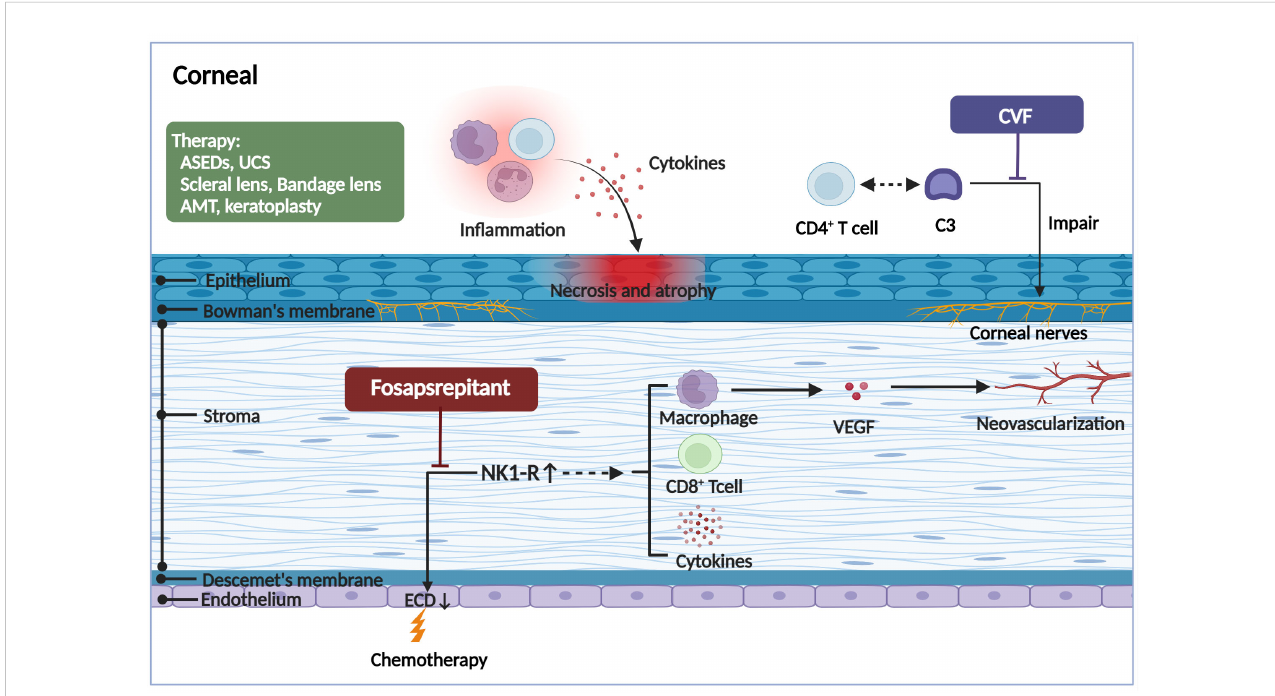
FIGURE 3 The pathogenic mechanism in the corneal of ocular GVHD and treatment. The corneal may appear the corneal epithelial impairment, a lower endothelial cell density, hemangiogenesis, and corneal neurosensory abnormalities in ocular GVHD. The corneal epithelial impairment including atrophy and necrosis, the vacuolization of epithelial basal cells, and stromal edema, all of which are likely associated with the in fi ltration of immune cells and the stimulation of in fl ammatory cytokines. The reduction of the corneal endothelial cells and formation of neovascularization might be associated with increased expression of the proin fl ammatory marker NK1R. Fosaprepitant, the inhibition of the SP-NKR1 axis, through topically applied substantially ameliorated the clinical manifestations of ocular GVHD. In addition, the aberrant complement C3/CD4+ T-cell axis activation might coordinate corneal nerve damage. However, the speci fi c mechanism needs to be further investigated. By forming a biochemically stable convertase to rapidly hydrolyze mammalian C3, localized cobra venom factor prevents corneal sensation loss in ocular GVHD. In addition, the therapies for ocular GVHD patients with severe corneal impairment include serum eye drops, umbilical cord serum, scleral lenses, bandage soft contact lenses, amniotic membrane grafts, and keratoplasty. ASEDs, autologous serum eye drops; UCS, umbilical cord serum; AMT, amniotic membrane graft; CVF, cobra venom factor; ECD, endothelial cell density; NK1R, neurokinin-1 receptor; VEGF, vascular endothelial growth factor. (Created with